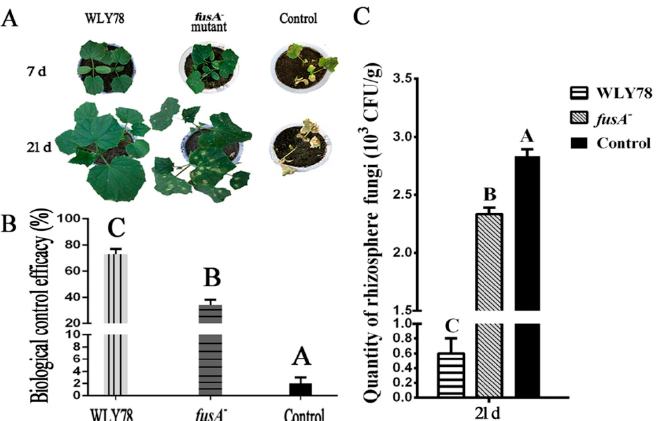
Figure 5. The disease symptoms of Fusarium wilt of cucumber after treatment with P. polymyxa WLY78, the fusA − mutant, and water, respectively ( A ). Biological control e ffi cacy (%) of P. polymyxa WLY78, the fusA ‐ mutant, and water against Fusarium wilt of cucumber ( B ). Quantities of F. oxysporum f. sp. cucumerium in rhizosphere after treatment with P. polymyxa WLY78, the fusA ‐ mutant, and water ( C ). Error bars indicate standard deviations among triplicates. Different letters indicate significant differences at p < 0.01 according to the Duncan multiple range test.